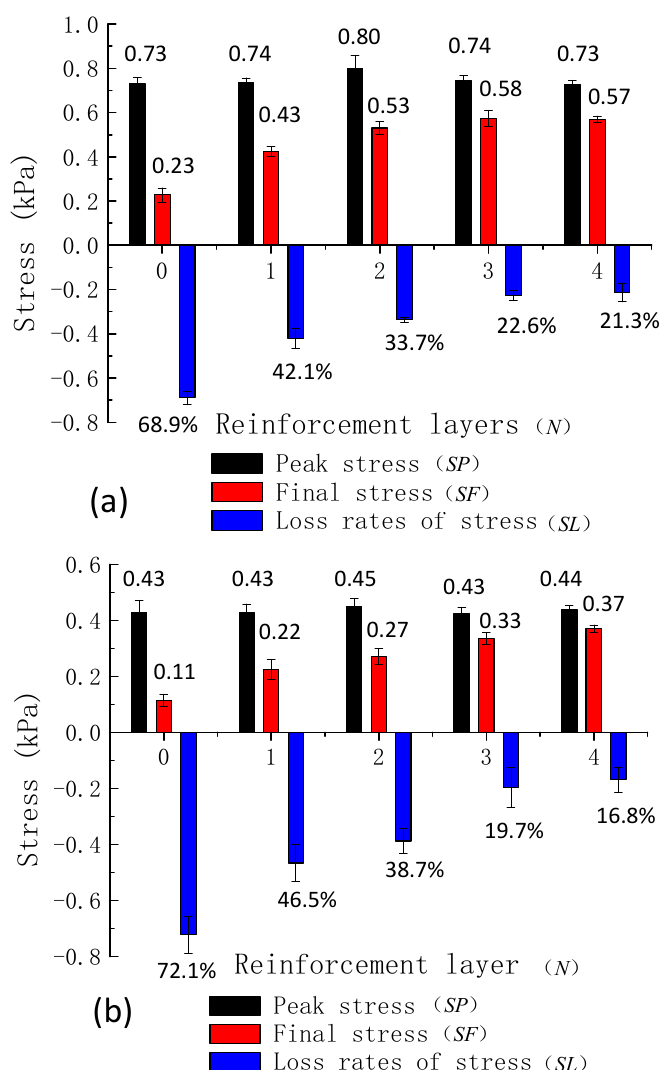
Figure 9. The characteristics of dam internal stress, ( a ) stress of sensor BX-201; ( b ) stress of sensor BX-202, SL = ( SF − SP ) / SP × 100 .